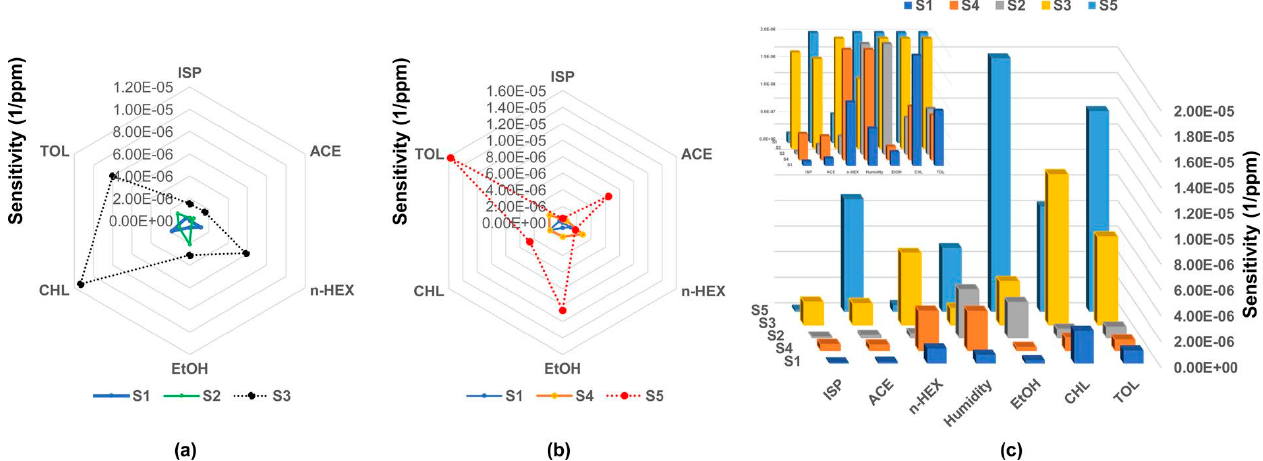
Figure 12. Sensitivity values (1/ppm) of ( a ) sensors S1–S3, ( b ) sensor S1–S4–S5 in radar plots, and ( c ) sensors S1-S5 in bar chart representation, for six different analytes under 0% RH provided with